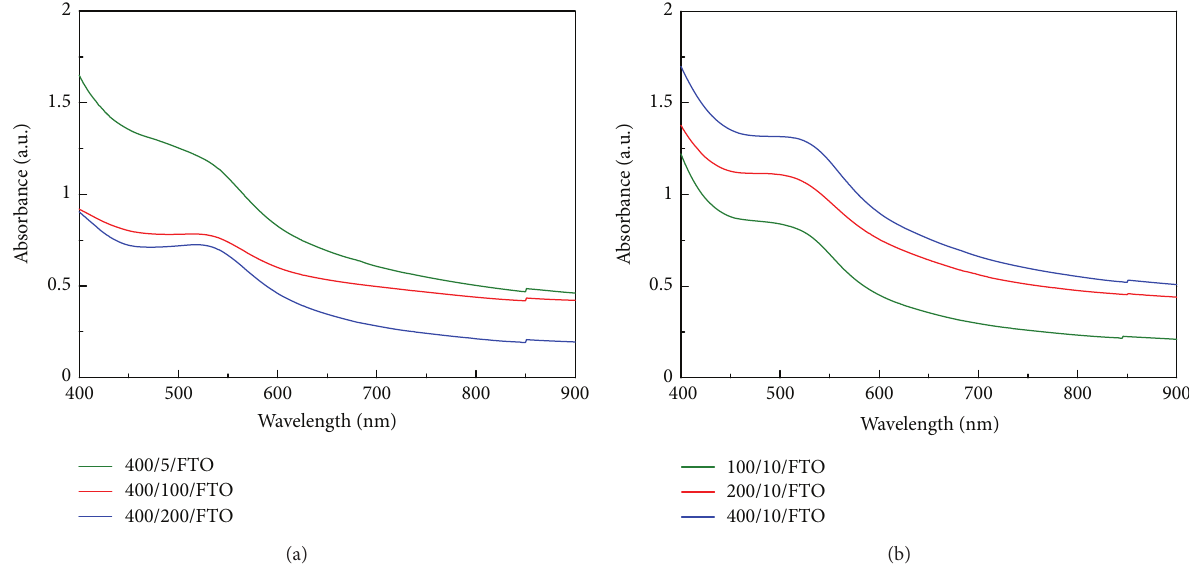
Figure 6: The light absorption of double-layer structures with different TiO 2 particle sizes in the (a) bottom and (b) top layers,